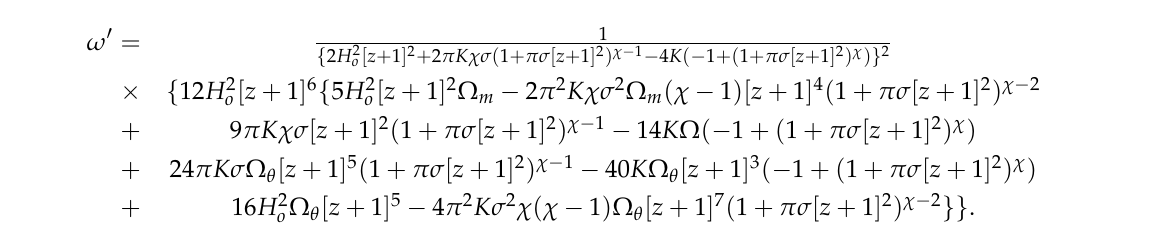
In Figure 4, the graph is plotted for ω (cid:48) vs z at H o = 67.4, Ω m = 0.315, σ = − 40, χ = 3, and Ω θ = 0.15, 0.17, 0.19 corresponding to blue, red, and green, respectively. The term ω (cid:48) shows negative behavior depending on the choice of χ > 0 and σ > 0.